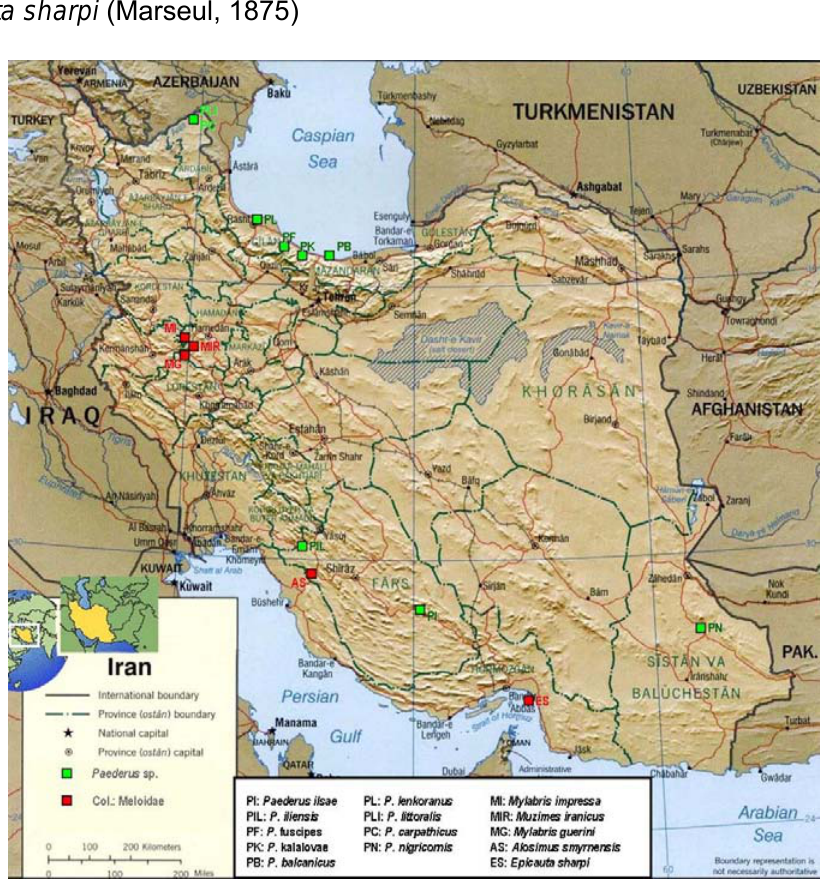
Figure 6. Distribution map of medically important beetles in